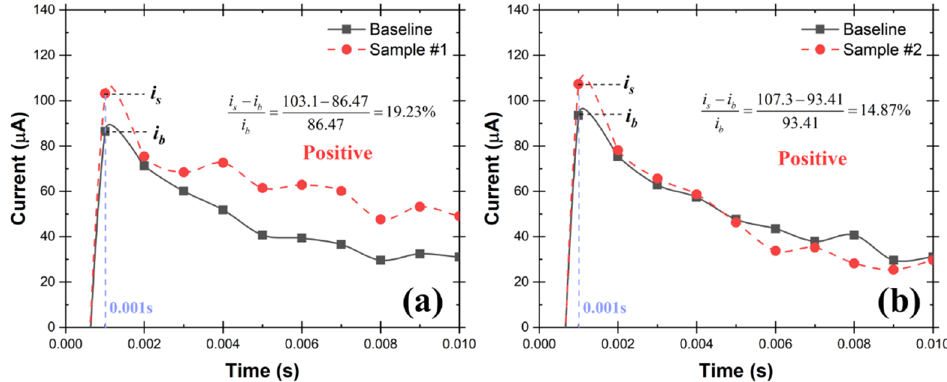
Figure 12. Chronoamperograms of UFC-19 sensor for collected samples (0.5 cp/mL SARS-CoV-2 virions) from two repeated air sampling experiments ( a , b ) using the test rig with Nebulizer and Coriolis Sampler. The current at 0.001 s of the collected samples is more than 2% higher than the baseline current indicating the samples are Positive. Table 2. Simulated air sensing with PRONEB nebulizer and collection with Coriolis Sampler.